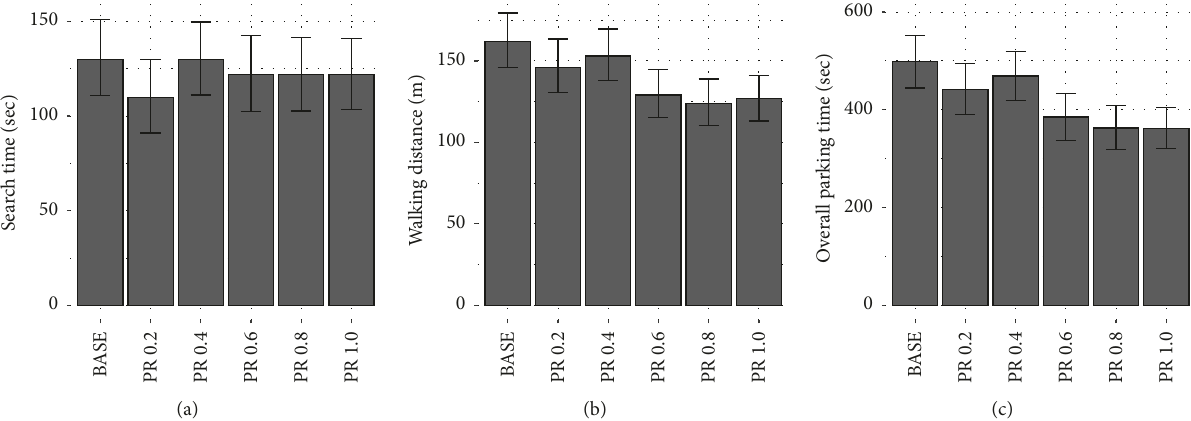
Figure 9: Results for at the system level for on-street parking in high occupancy area only: (a) search time, (b) walking distance, and (c) total parking time, for regular cars and smart cars, for a 95% confidence interval at afternoon peak